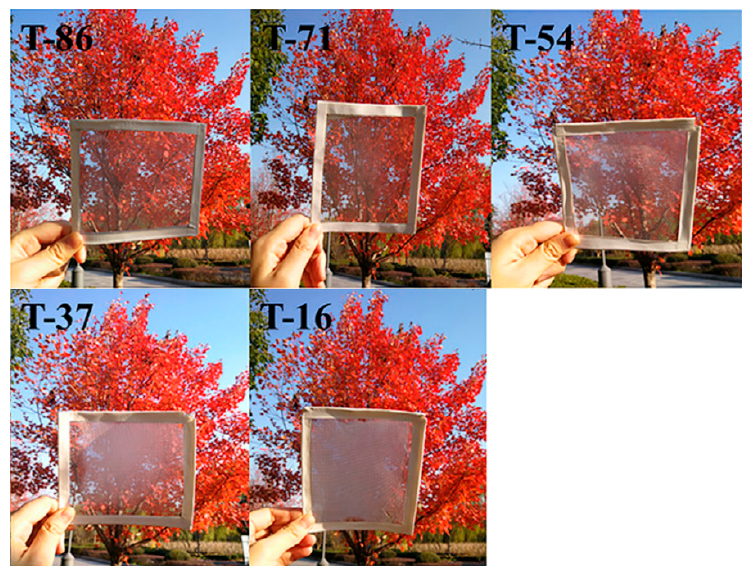
Figure 9. Photographs of PDMS/PMMA–chitosan transparent air filters at different transparencies (adapted from [116] ). PMMA: polymethyl methacrylate.